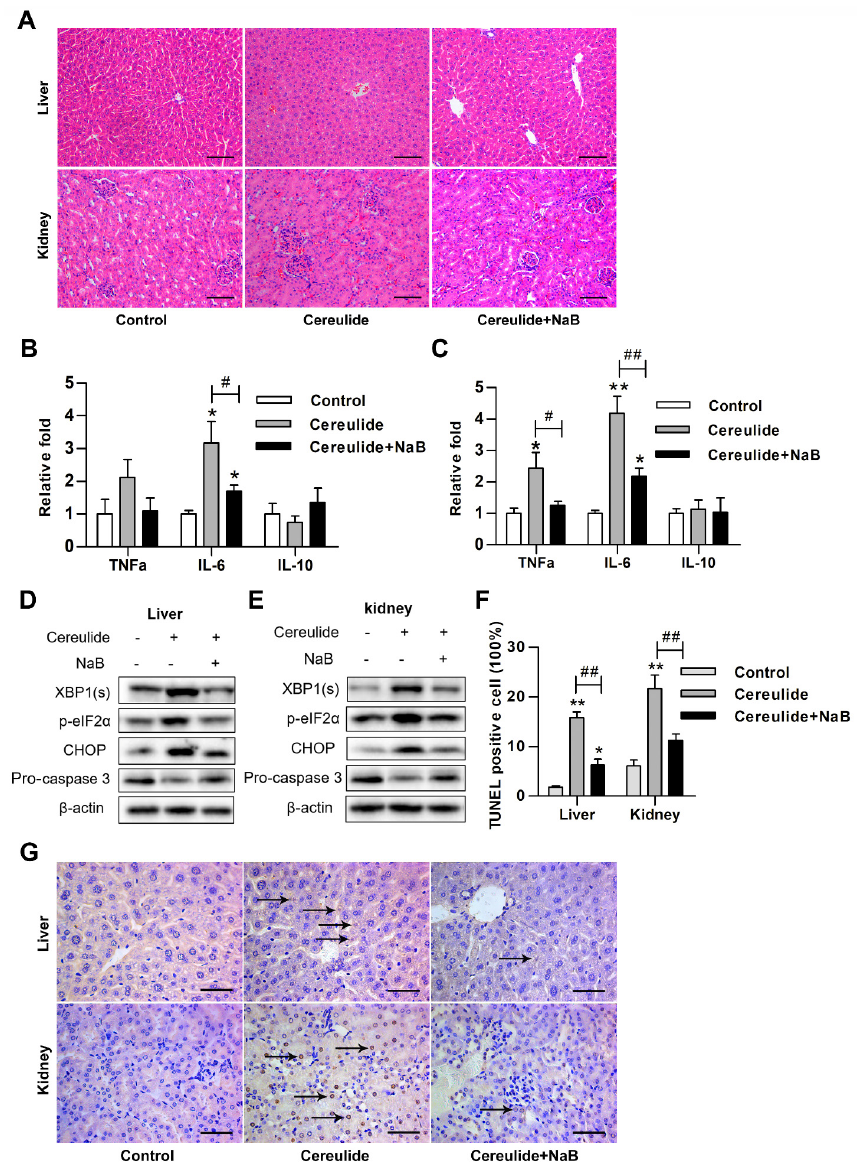
Figure 5. NaB relieves cereulide ‐ induced liver and kidney damage by inhibiting ER stress. ( A ) Representative images of H&E ‐ stained liver and kidney tissues from cereulide + NaB ‐ treated mice and cereulide ‐ treated mice (×200 magnification). ( B , C ) The mRNA levels of TNF- α , IL-6 and IL-10 were detected in liver and kidney tissues by RT-qPCR, n = 5. ( D , E ) Western blot analysis for XBP1(s), p-eIF2 α , CHOP and Cas- pase3 in the liver and kidney tissues of mice that exposed to cereulide (50 µ g/kg) were treated with NaB (100 mg/kg) for 28 days. ( F , G ) TUNEL analysis of apoptosis level in liver and kidney tissue of mice exposed to cereulide (50 µ g/kg) and cereulide + NaB (100 mg/kg) ( × 400 magnification). Arrows indicated apoptotic cells. Data are presented as the mean ± SD ( n = 6). For all panels, * p < 0.05 and ** p < 0.01 compared to the control group; # p < 0.05 and ## p < 0.01 compared to cereulide + NaB